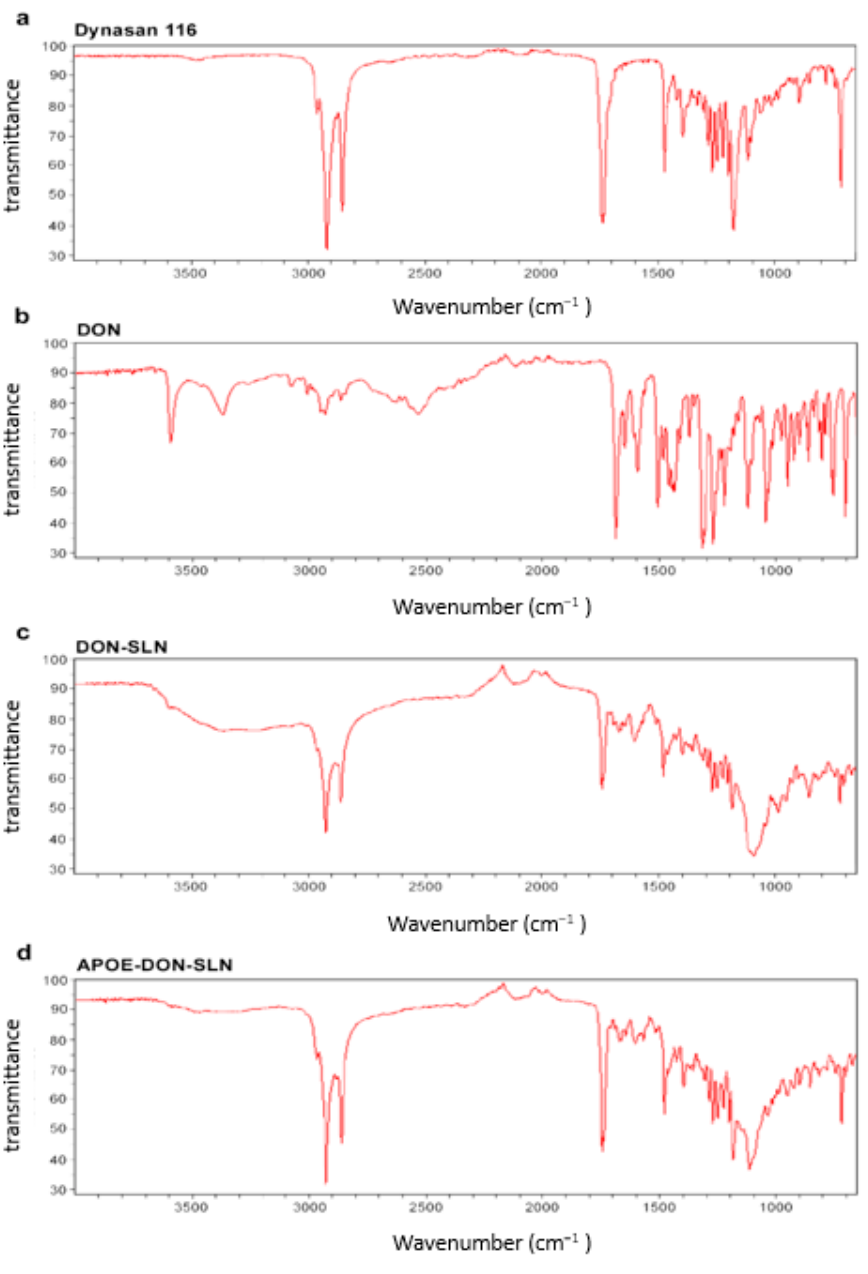
Figure 4. FTIR spectra of ( a ) dynasan 116, ( b ) donepezil HCl (DON), ( c ) non-targeted (DON-SLN), and ( d ) targeted SLNs (APOE-DON-SLN).